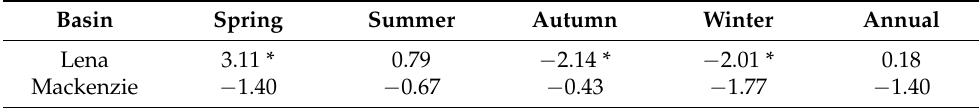
Figure 5. Runoff variations in the MRB and LRB during 2003–2016. ( a ) annual runoff depth; ( b ) seasonal runoff depth. Table 4. The results of the TFPW-MK test for the runoffs in Lena and Mackenzie. Values exceeding 1.96 represent upward signify trends, whereas those less than 1.96 represent decreasing trends at α < 0.05. Basin